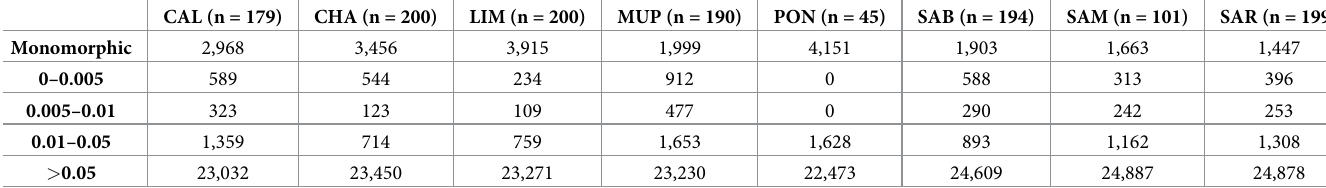
Table 1. Number of autosomal SNPs per breed 1 classified into 5 classes of minor allele